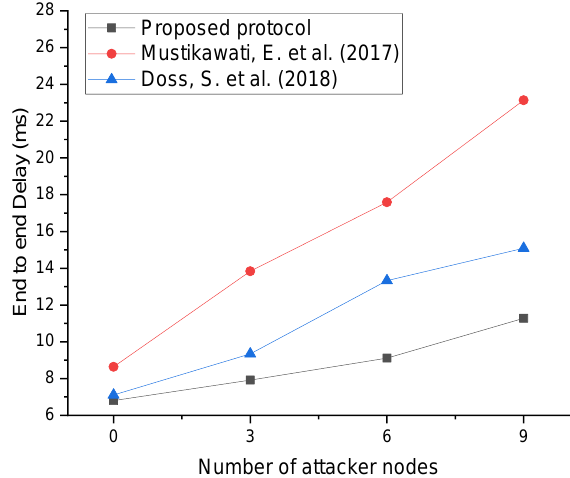
Figure 14. End-to-end delay under Jellyfish delay variance attacks [20,37].